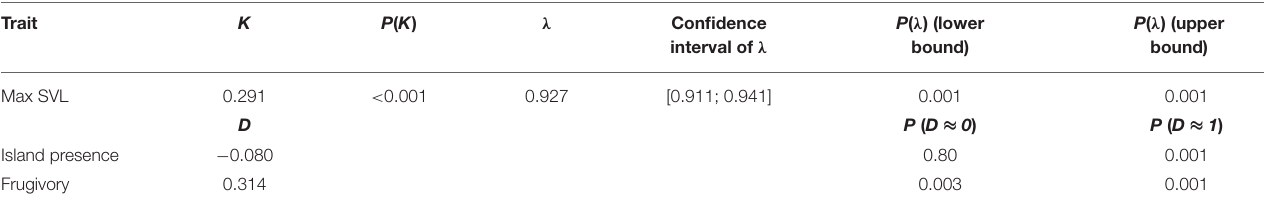
P of null model of Brownian motion (BM) (see Methods for details). K ≈ 0 no influence of phylogeny; K ≈ 1 trait evolution according to BM model; K > 1 trait is phylogenetically clustered; λ ≈ 0 no influence of phylogeny; λ ≈ 1 trait evolution according to BM model; D < 0 trait values are phylogenetically clustered; D ≈ 0 trait evolution according to BM model; D ≈ 1 no influence of phylogeny.